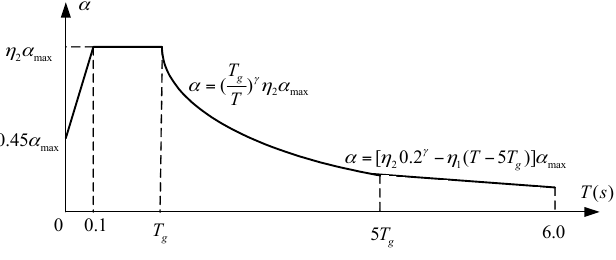
Figure 16. Seismic influence coefficients in the code for seismic design of buildings.